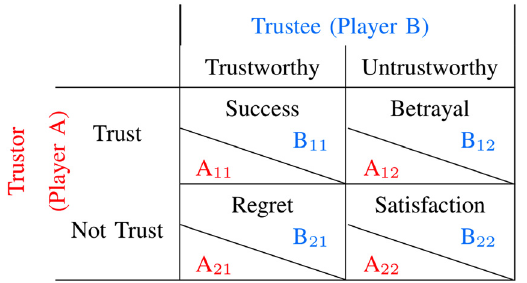
Figure 1: Payo ff matrix for the trustor ( red ) and trustee ( blue ) in a trust – trustworthiness interaction. Regret here is speci fi c to not trusting/being trusted when trust would have been ful fi lled and is distinct from any emotion linked to